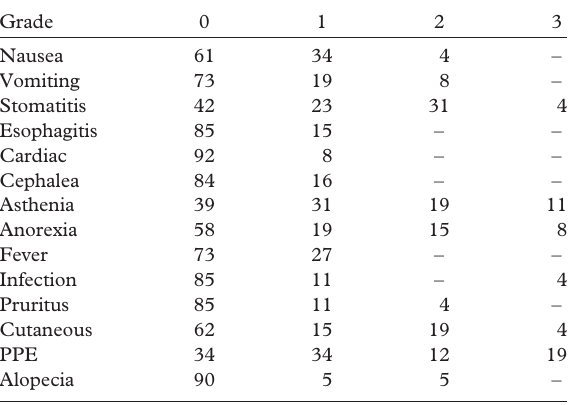
Figures represent percentage of